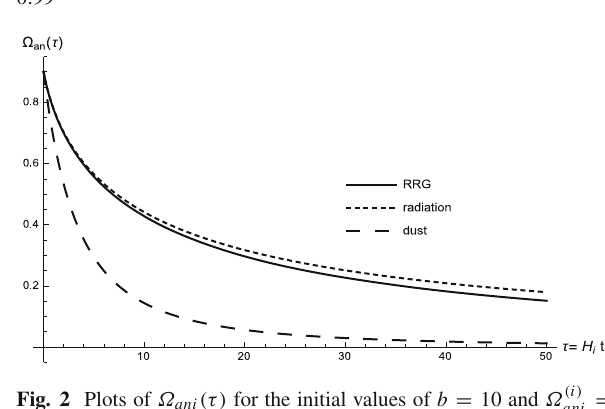
Fig. 1 Plotsofscalefactorsfortheinitialvaluesof b = 10 and Ω ( i ) 0 . 99